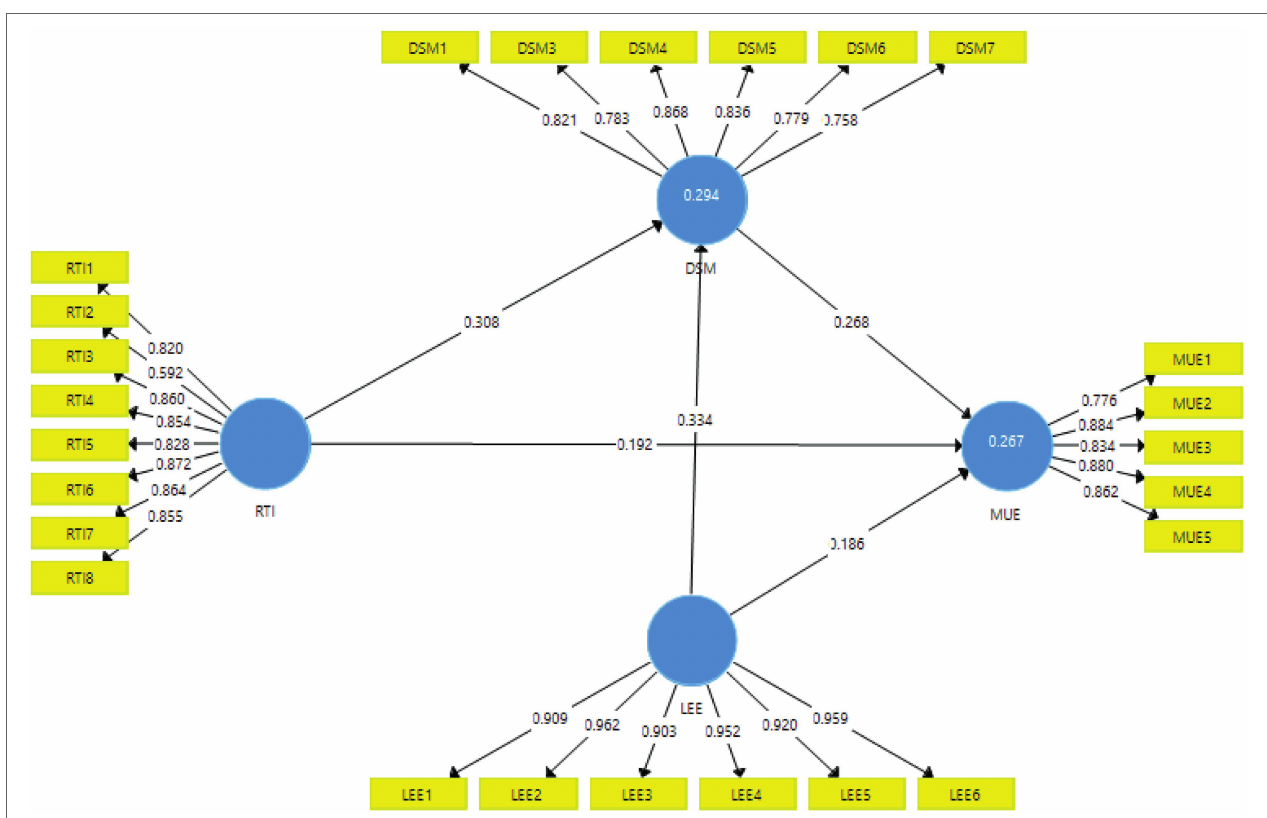
FIGURE 2 | Measurement model